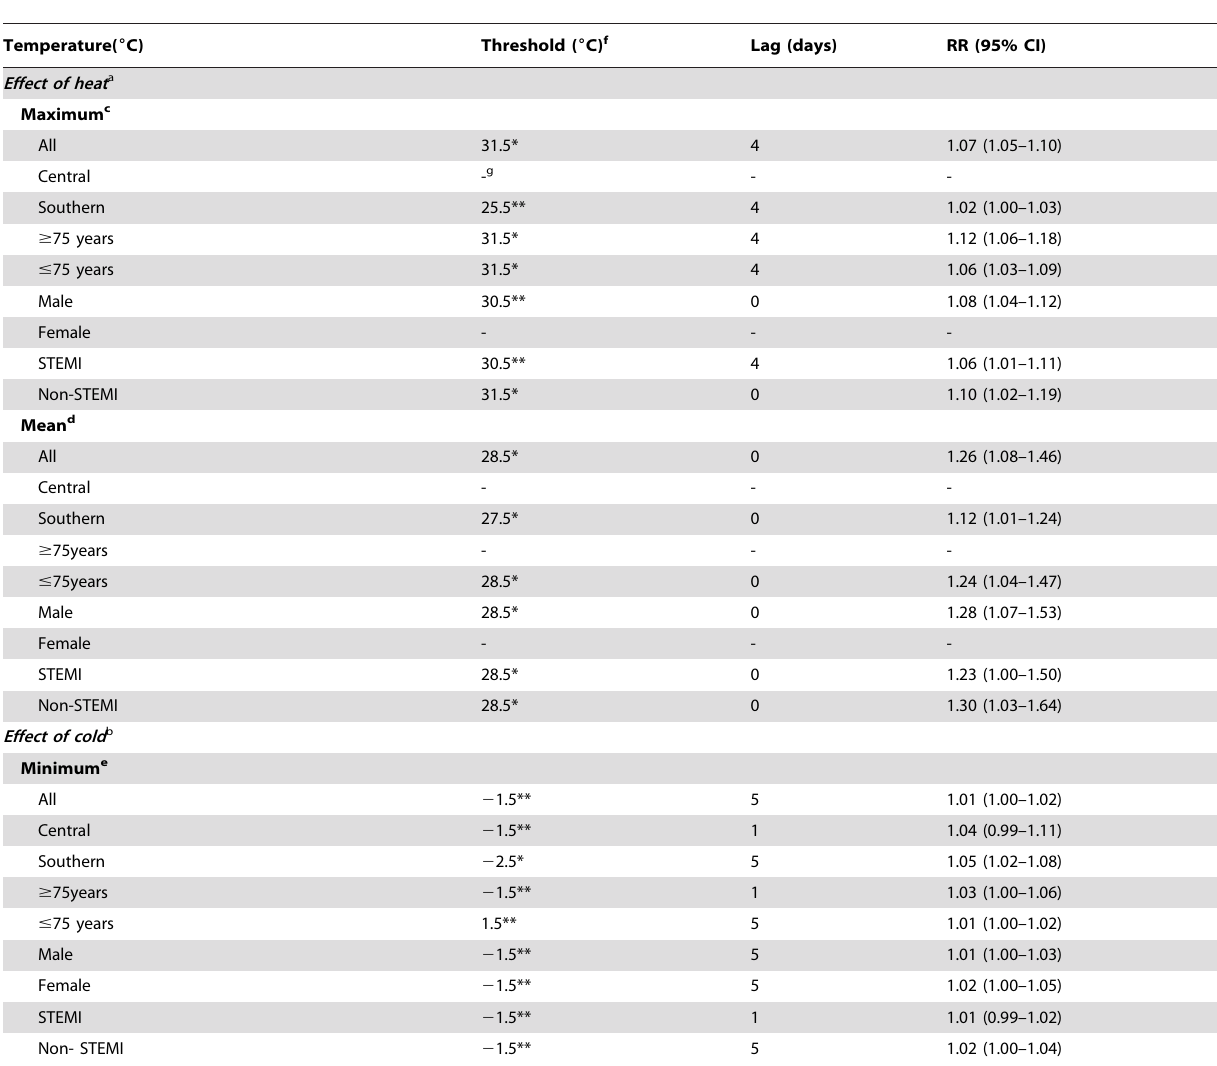
Table 3. Relative Risk of Myocardial Infarction per 1 u C Change in Temperature above Threshold temperature by Subgroup.